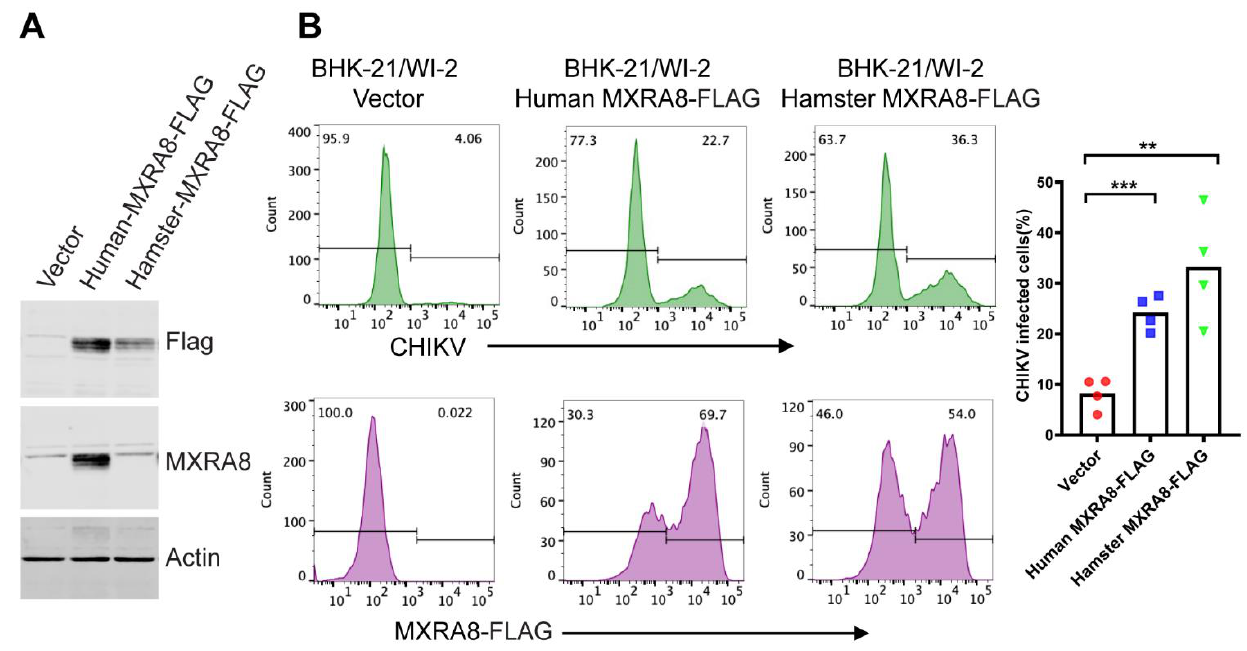
Figure 5. CHIKV infection of BHK-21/WI-2 cells is rescued by expression of human or hamster MXRA8. ( A ) Protein expression by human or hamster MXRA8 plasmids. BHK-21/WI-2 cells were transfected with constructs encoding human-MXRA8-Flag or hamster-MXRA8-Flag, or with empty vector (pcDNA3.1), and cultured for 24 h. Cell lysates were analyzed by Western blot with an antibody to the Flag tag or with an antibody that specifically recognizes human MXRA8. ( B – C ) CHIKV infection in BHK-21/WI-2 cells expressing human or hamster MXRA8. BHK-21/WI-2 cells were transfected with human-MXRA8-Flag, hamster-MXRA8-Flag or empty vector and cultured for 24 h. Cells were then infected with CHIKV. After a 1 h infection the cells were incubated overnight in medium containing 20 mM NH 4 Cl to prevent secondary infection, and MXRA8 expression and CHIKV infection were quantitated by flow cytometry. ( B ) The flow data on the left are a representative example of 4 independent experiments. The bar graph on the right shows the mean and individual data points of the % infection from 4 independent experiments. Unpaired t test was performed to assess the statistical significance of differences in CHIKV infection in cells expressing human/hamster MXRA8 compared to that in vector control. **, p < 0.01; ***, p < 0.001. The difference between infection of cells expressing human vs. hamster MXRA8 is not statistically significant ( p = 0.167).